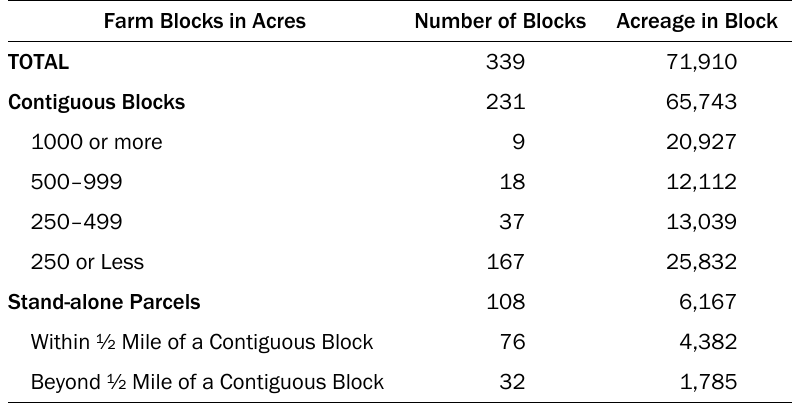
Table 2. Contiguous and Stand Alone Farms by Acreage, 2007